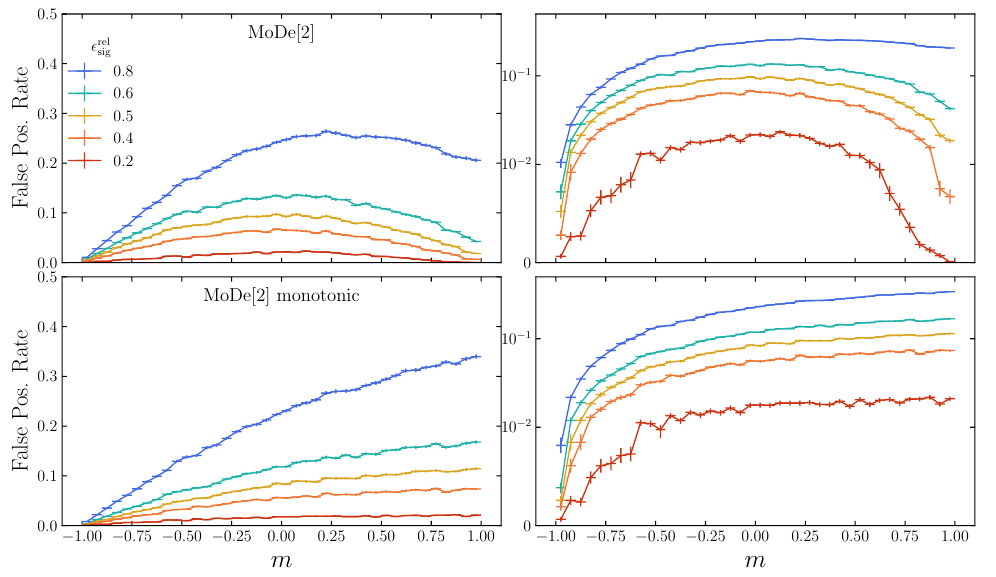
Figure 4 . Top: false positive rate versus mass at various signal efficiencies for non-monotonic MoDe [2] on the modified simple-model example; see eq. (3.3). Bottom: false positive rate for monotonic MoDe [2]. N.b. , the right panels show the same curves as the left but on log scales.